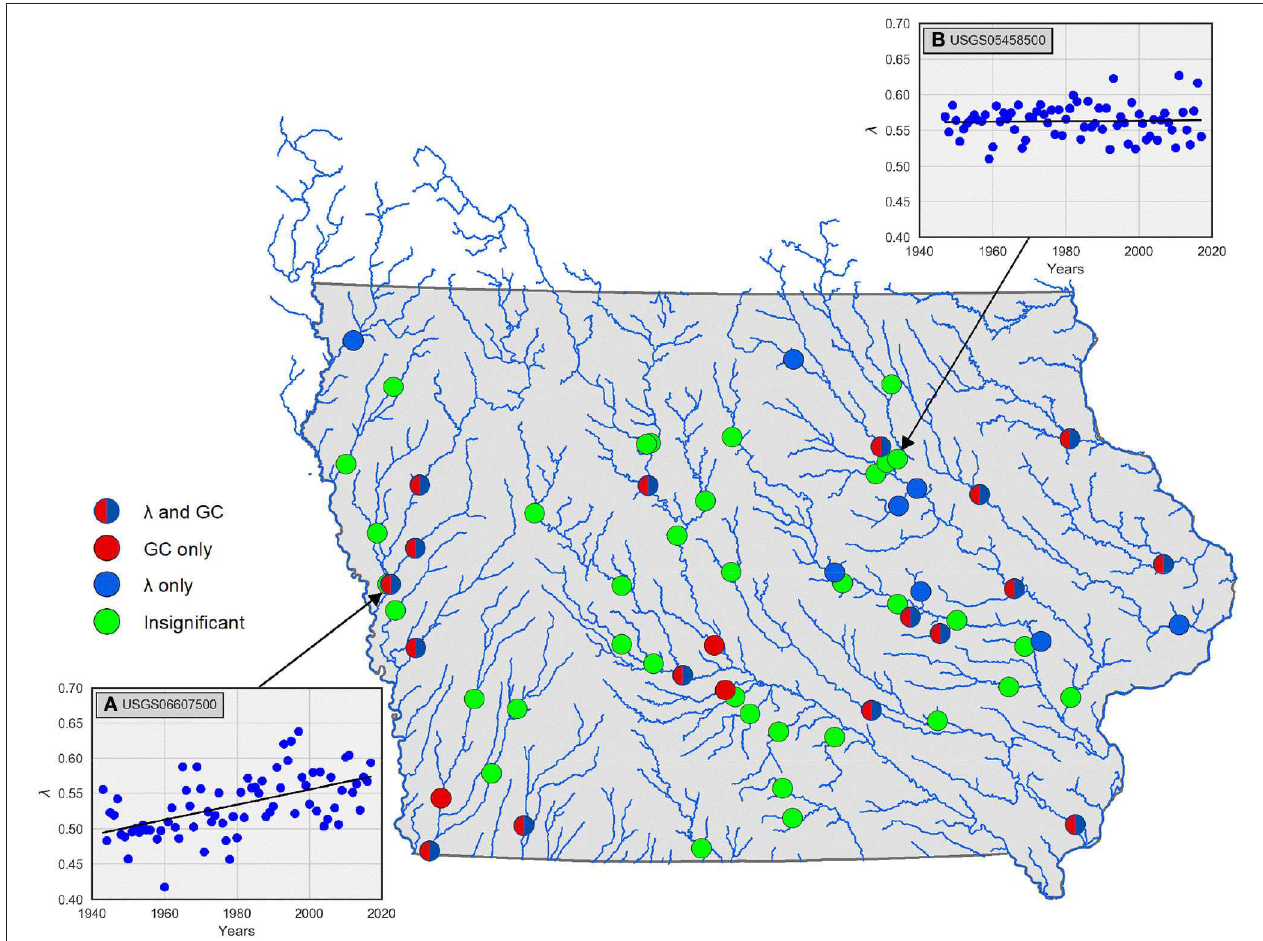
FIGURE 12 | Illustration of USGS sites with statistically significant temporal trends of streamflow predictability. The solid blue circles represent stations with evolutive trend in terms of λ only; solid red circles represent stations with evolutive trend in terms of GC only; circles that are both red and blue represent stations with evolutive trend in terms of both λ and GC ; light green circles do not show any trend. Insets (A,B) are examples of scatterplots with and without significant temporal trends,